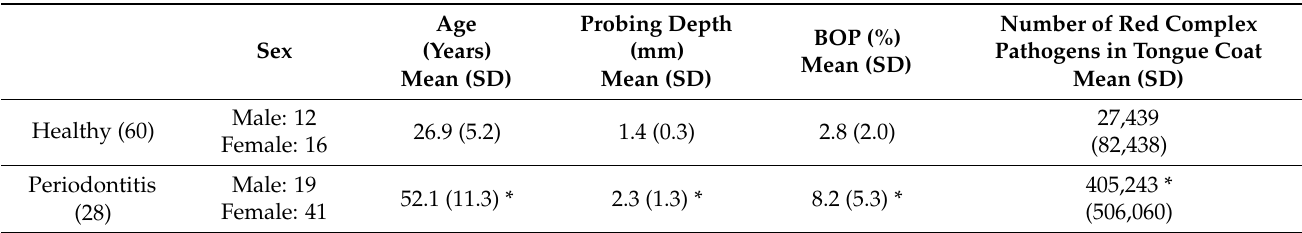
Table 1. Patient